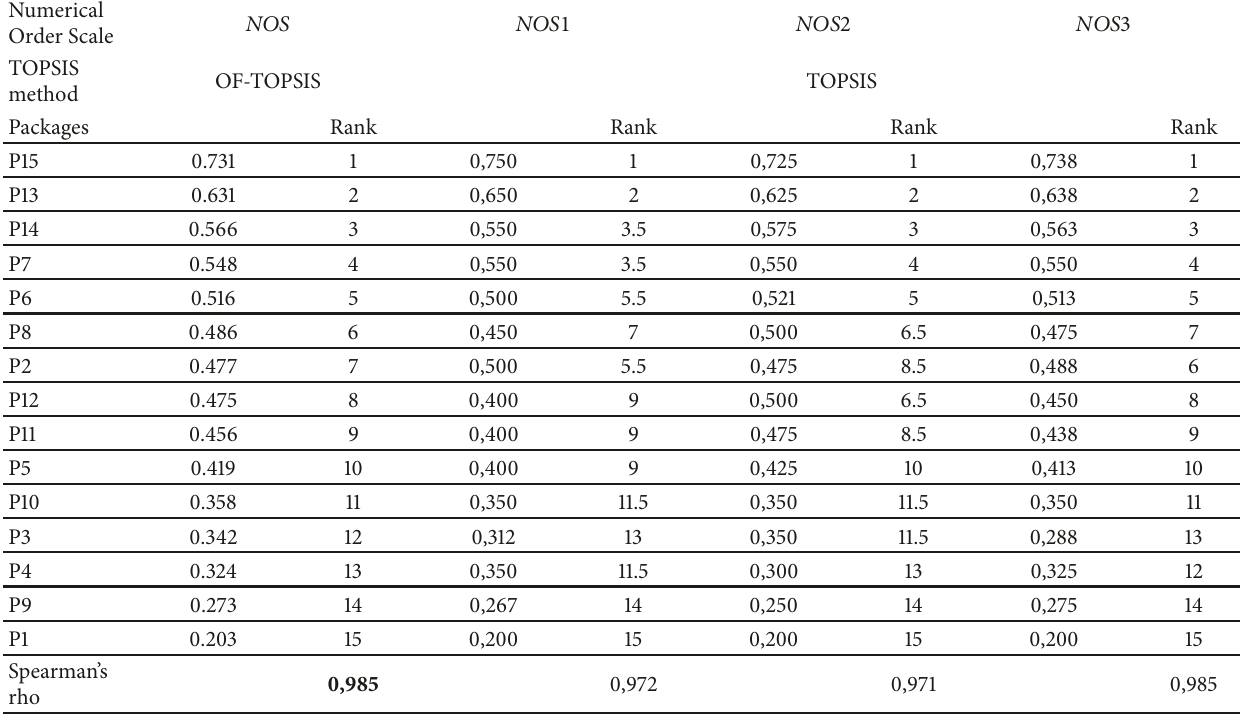
Table 8: The negotiation packages’ rankings determined by OF-TOPSIS